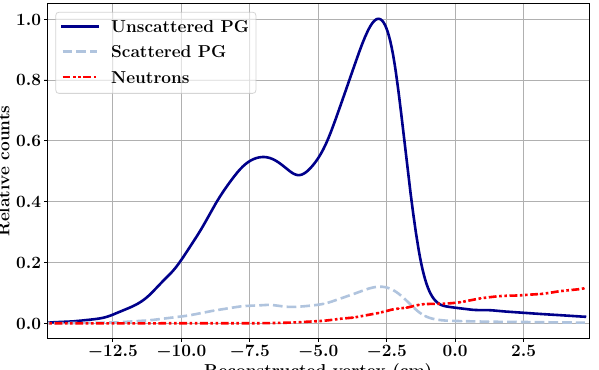
Figure 11. Vertex distributions of different secondary particles generated by a 100 MeV proton beam impinging on the spherical phantom head described in Jacquet et al. 18 . Data are obtained by MC simulation (Geant4.10.4.p02 toolkit with the QGSP-BIC-EMY physics list); the detector is not simulated. The contribution of PG scattered in the phantom is reported separately. It can be observed that their profile has the same shape as the one from unscattered PGs and therefore they constitute a valuable signal. The contribution of secondary neutrons (in red) is not constant and cannot be easily rejected by TOF without compromising the measurement of the PG profile fall-off. Data are taken from Jacquet et al. 18